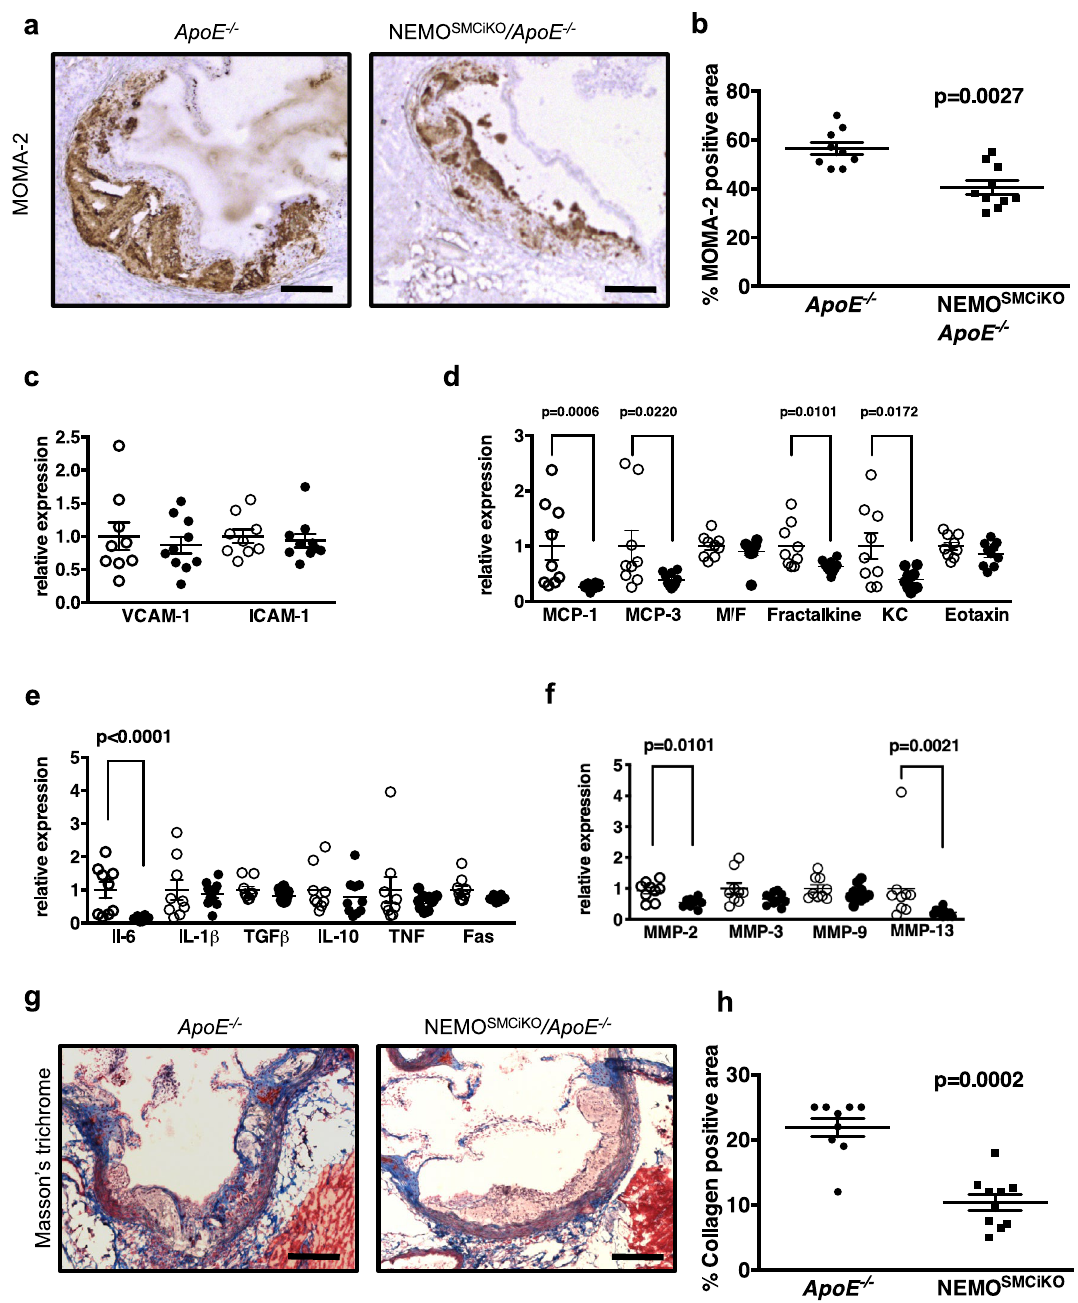
Figure 2. Reduced monocyte recruitment and inflammation in the aortas of ApoE − / − mice with inducible deletion of NEMO in smooth muscle cells. Male NEMO SMCiKO / ApoE − / − mice and ApoE − / − mice were fed a HFD for 10 weeks before sacrifice. ( a ) Representative pictures from immunostainings of atherosclerotic lesions of ApoE − / − or NEMO SMCiKO / ApoE − / − mice with antibodies against MOMA-2. Scale bars = 0.1 mm. ( b ) Graph showing quantification of macrophage content in the lesions of ApoE − / − (n = 9) or NEMO SMCiKO / ApoE − / − (n = 10) mice (Mann–Whitney test). RNA was isolated from the aortic arches of ApoE − / − (open circles, n = 9) or NEMO SMCiKO / ApoE − / − (filled circles, n = 10) mice and the relative expression of adhesion molecules ( c ), cytokines ( d ), chemokines ( e ) and metalloproteases ( f ) was analyzed. Results represent mean ± SEM (Mann– Whitney U-test). ( g ) Representative pictures of Masson Trichrome staining in atherosclerotic lesions of ApoE − / − or NEMO SMCiKO / ApoE − / − mice. Scale bars = 0.1 mm. ( h ) Graph showing quantification of collagen content in the lesions of ApoE − / − (n = 9) or NEMO SMCiKO / ApoE − / − (n = 10) mice (Mann–Whitney